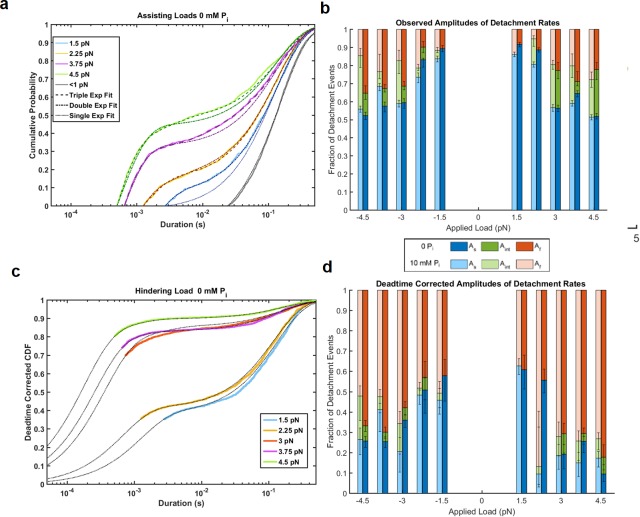
Attachment durations and fitted distributions.(a) Data from Figure 2a plotted as cumulative density functions (CDFs) with fitted distributions incorporating 1–3 exponential components as indicated in the symbol key, showing that for forces > 2.25 pN the sum of three exponential components was statistically justified. (b) The amplitudes (relative fraction) of each fitted rate constant, kf (Af, red), kint (Aint, green), and ks (As, blue) for data with 0 (dark bars) and 10 mM (light bars) added Pi. (c) Plot of the cumulative distribution functions at 0 mM Pi and hindering loads correcting for events that are missed by the experimental deadtime assuming exponential distributions (see Materials and methods). Most of the events lost in the deadtime are part of the fastest phase. Black dotted lines show fits to the data and extrapolate back to the zero CDF and duration (not shown). (d) Similar plot to panel b, but showing the amplitudes of each component after correcting for the experimental deadtime. The amplitude of the fast component (red) is considerably larger at each force than in panel b due to the loss of these events in the deadtime. Error bars are 68% confidence intervals from 500 rounds of bootstrapping for all panels.